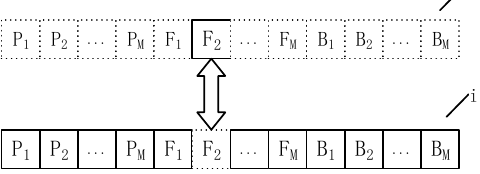
Figure 4. Mutation operation. Algorithm 2 Crossover and mutation 1.